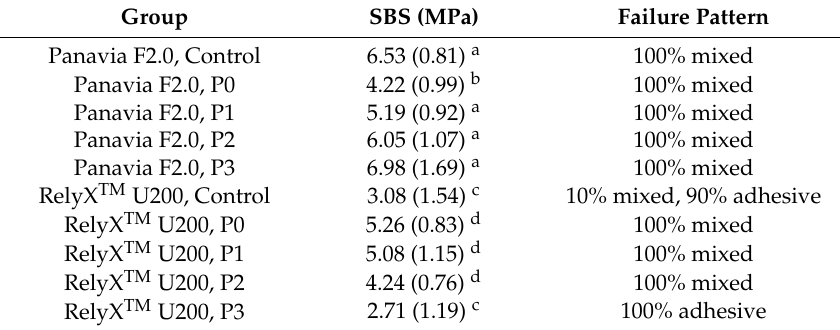
Figure 6. Results of a one-way analysis of variance of the shear bond strength of Panavia F2.0 ( n = 10). An * denotes a significant difference ( p < 0.05). Table 5. Shear bond strength (SBS) value and failure pattern analysis.